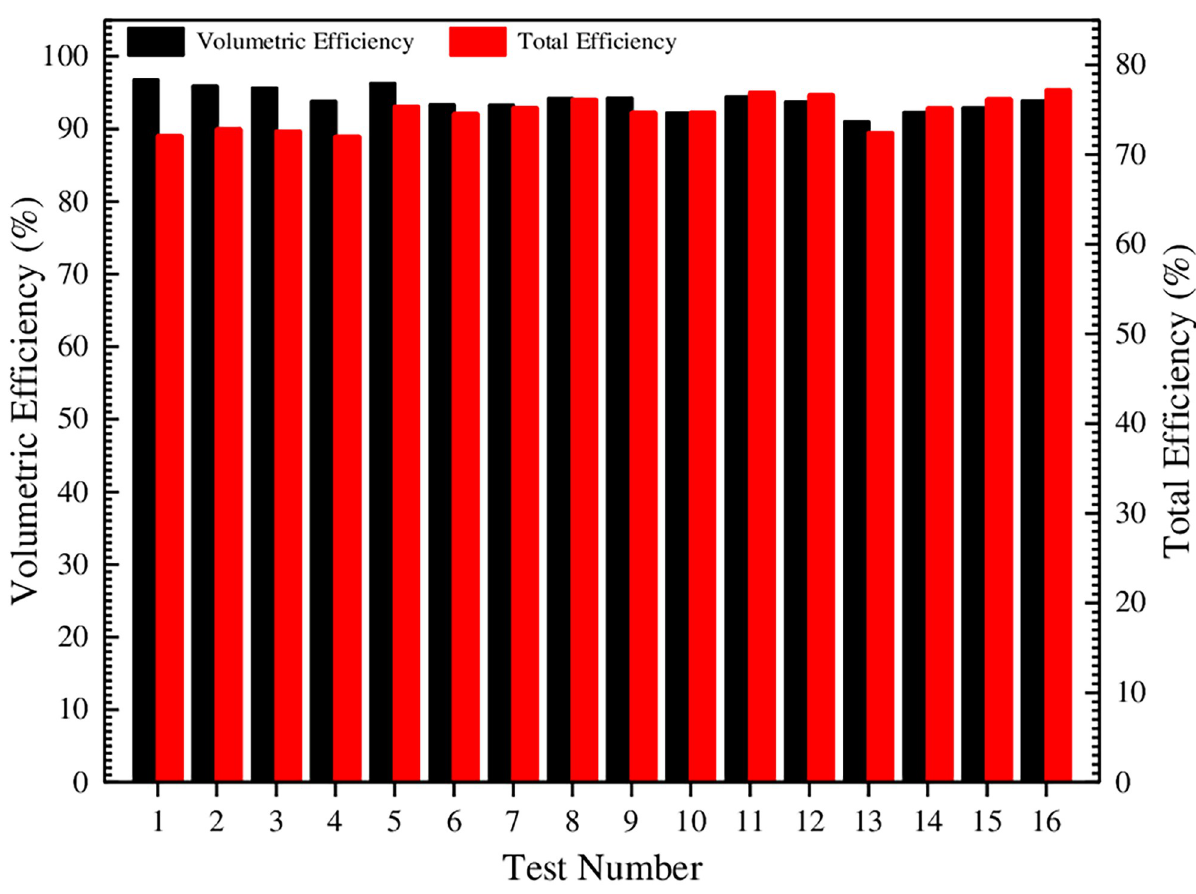
Fig 16. Comparison of volumetric efficiency and total efficiency under different test